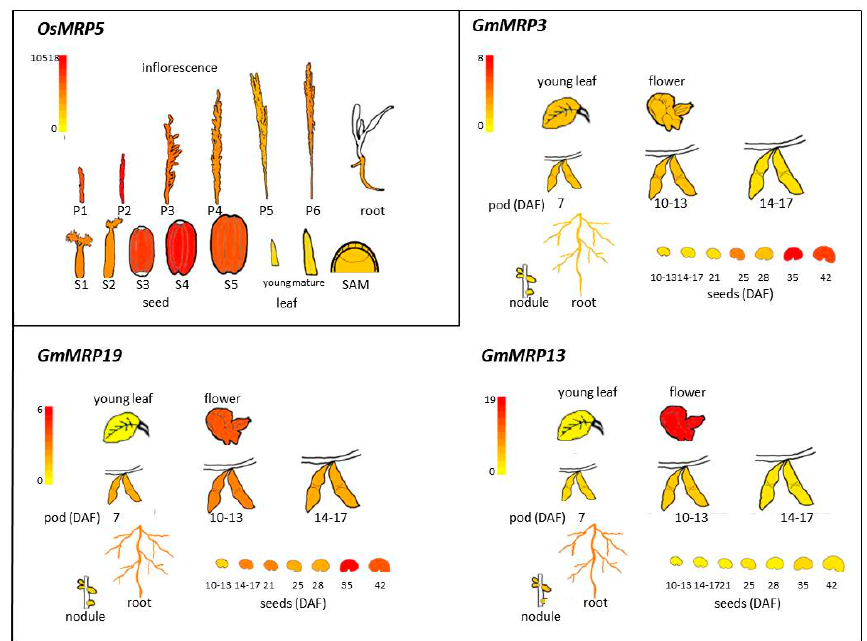
Figure 2. PA-MRP gene expression data in various rice and soybean organs and tissues were obtained from the rice and soybean eFP Browsers [47]. Rice MAS and soybean Severin data sources were used. For rice, the default signal threshold was used, while for the three soybean genes the signal threshold was arbitrarily put to the same value (8.00) in order to compare expression data between different genes.